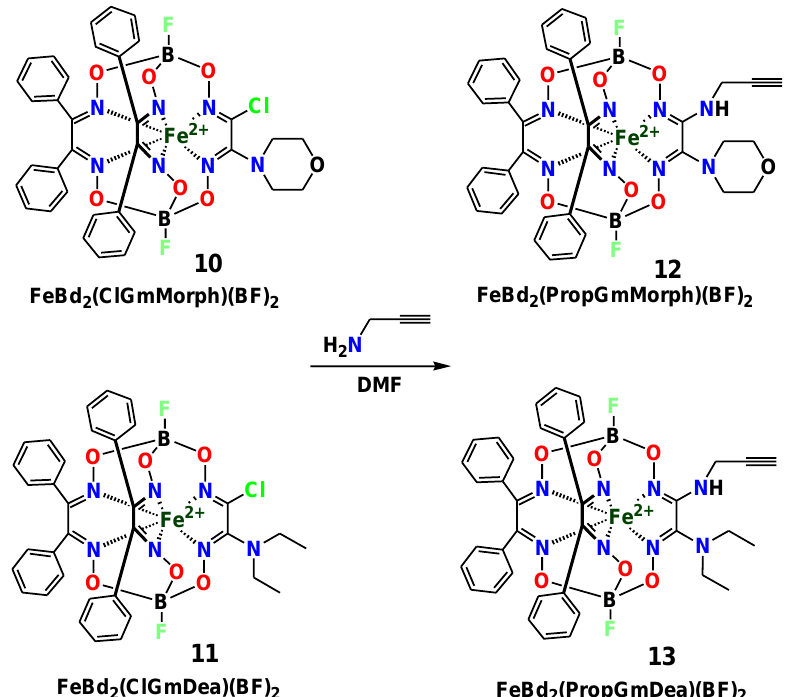
Scheme 3. Synthesis of the morpholine- and diethylamine-functionalized monopropargylamine-iron(II) clathrochelates.